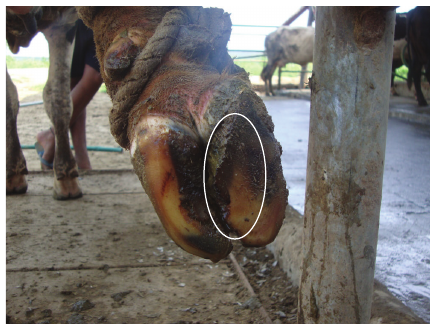
Figure 7: Overgrown sole.